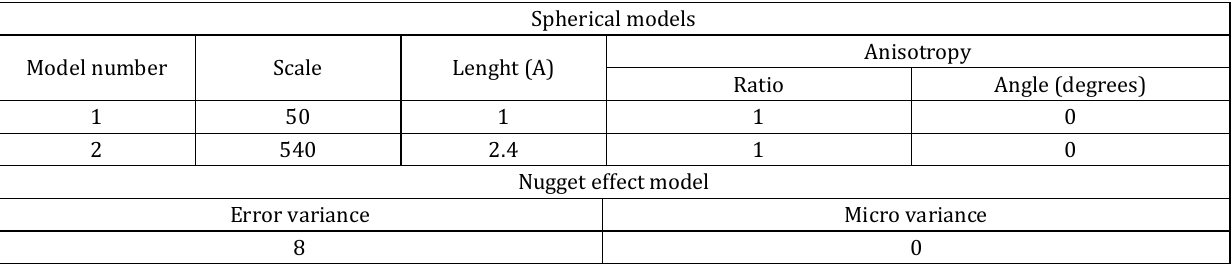
Table 6. Parameters of different theoretical models repeatedly adjusted with the empirical